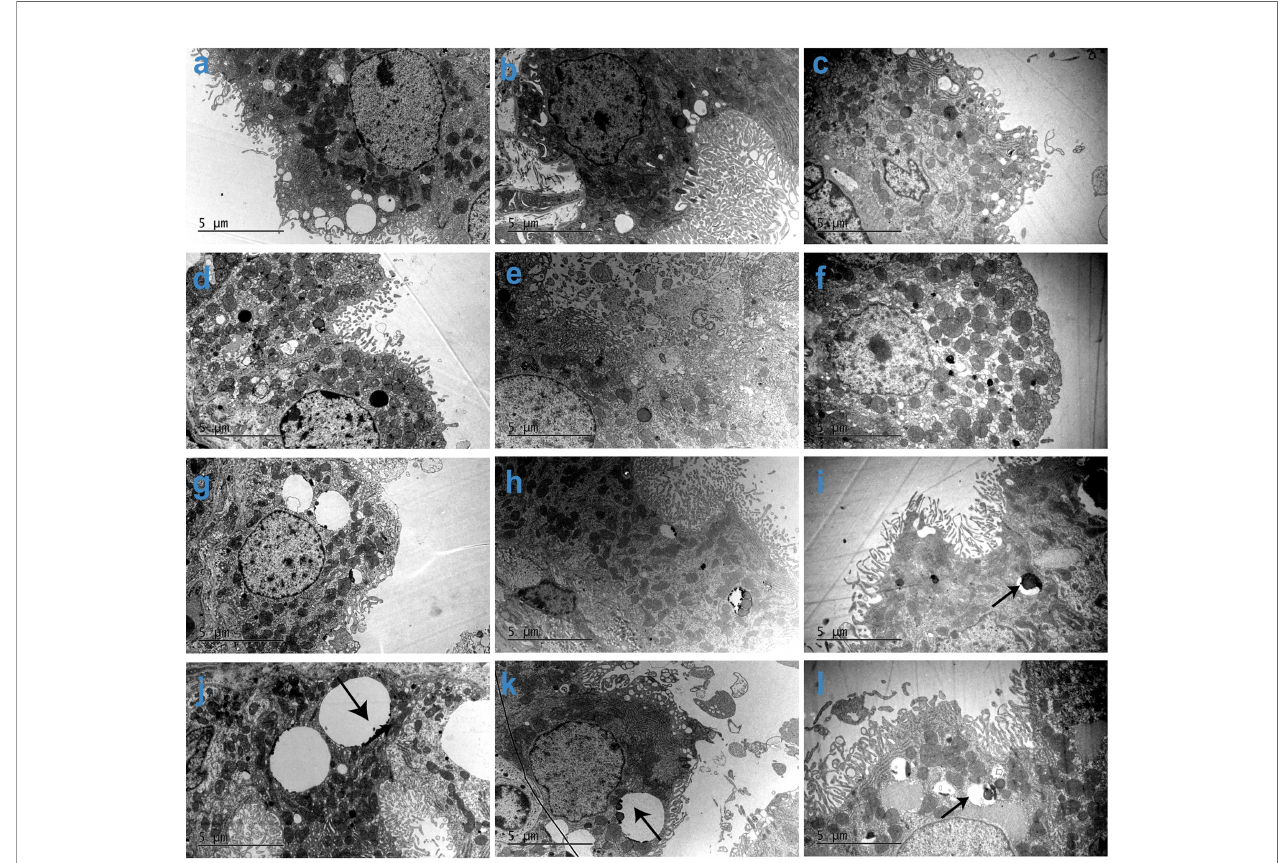
FIGURE 5 | Subcellular imaging of cynomolgus monkeys CP epithelium with 52-week administration of Jintrolong and after 104-/157-week recovery. (A) Excipient control group with 52-week administration. (B) Excipient control group after 104-week recovery. (C) Excipient control group after 157-week recovery. (D – F) 0.3 mg/kg/ week Jintrolong group at 52-week administration, after 104-week recovery, after 157-week recovery, respectively. (G – I) 1 mg/kg/week Jintrolong group at 52-week administration, after 104-week recovery, after 157-week recovery, respectively. (J – L) 3 mg/kg/week Jintrolong group at 52-week administration, after 104-week recovery, after 157-week recovery, respectively. Arrows in panels (I – L) indicate PEG in